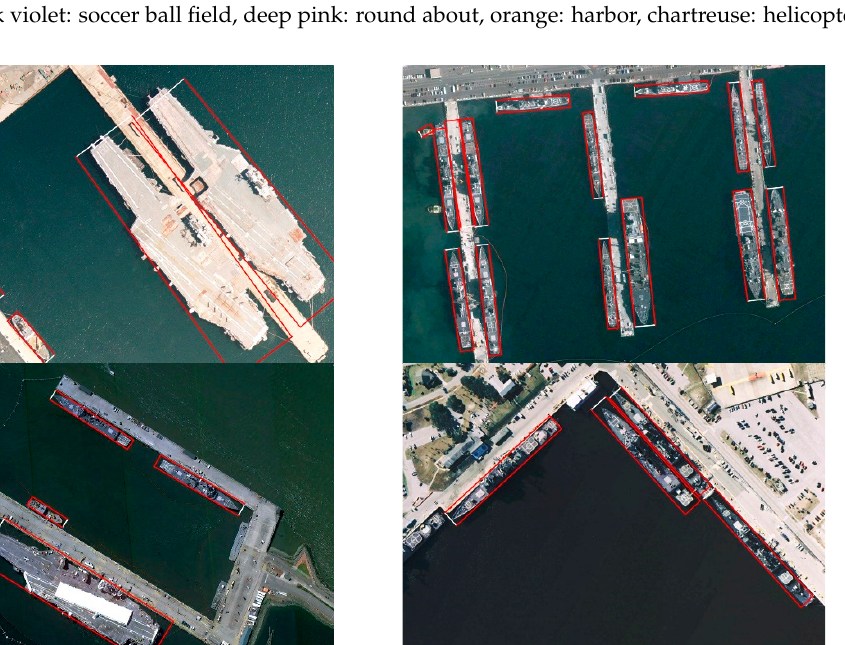
Figure 6. Detection results on HRSC2016.